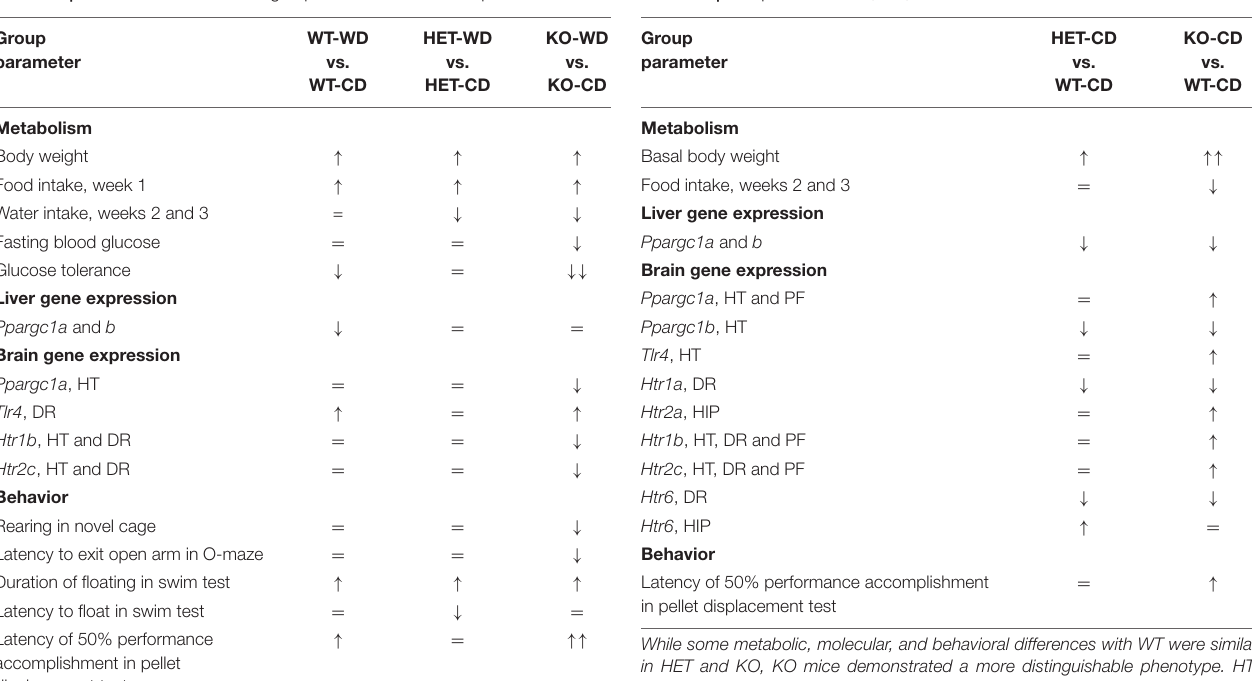
TABLE 6 | Comparison of HET, KO, and WT mice fed with the control diet. WT-WD Group HET-WD KO-WD vs. parameter vs. vs.